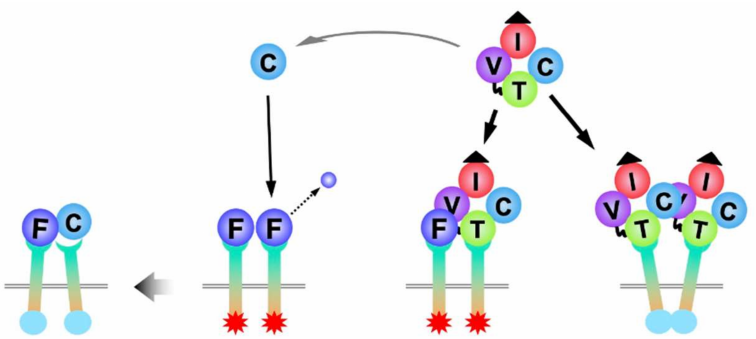
Figure 3. Multimolecular interactions among FGF-2, FGFR1, CCN2, and its single modular sub fragment. Activated form of FGFR1 is represented by stars in red, whereas silent form is represented by spheres in light blue. Letters indicate the same modules defined in Figure 2, with the exception of F, which denotes